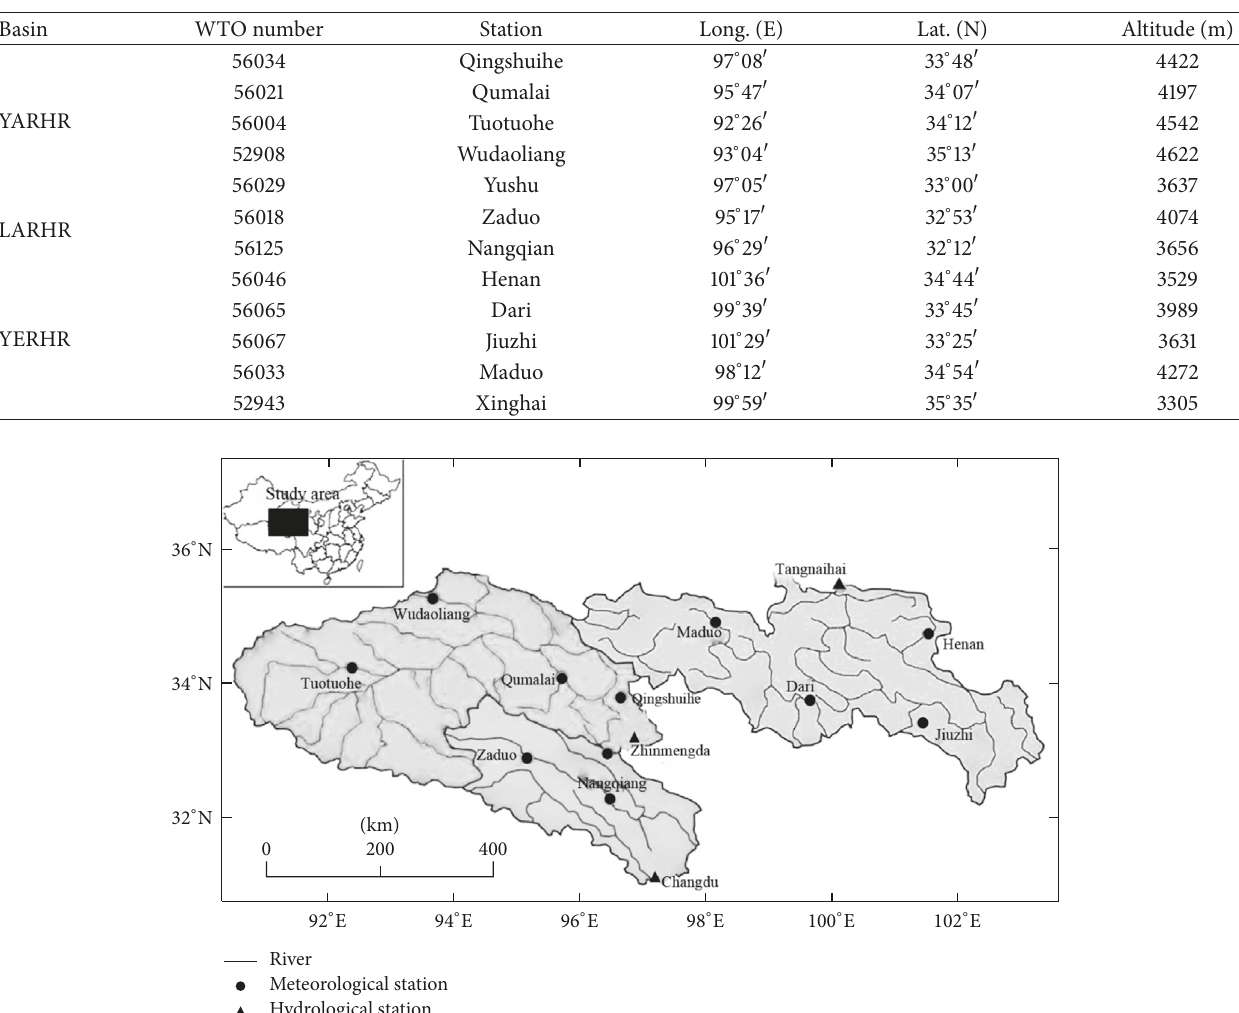
Figure 1: Distribution of meteorological stations, hydrological stations, and subregions in the